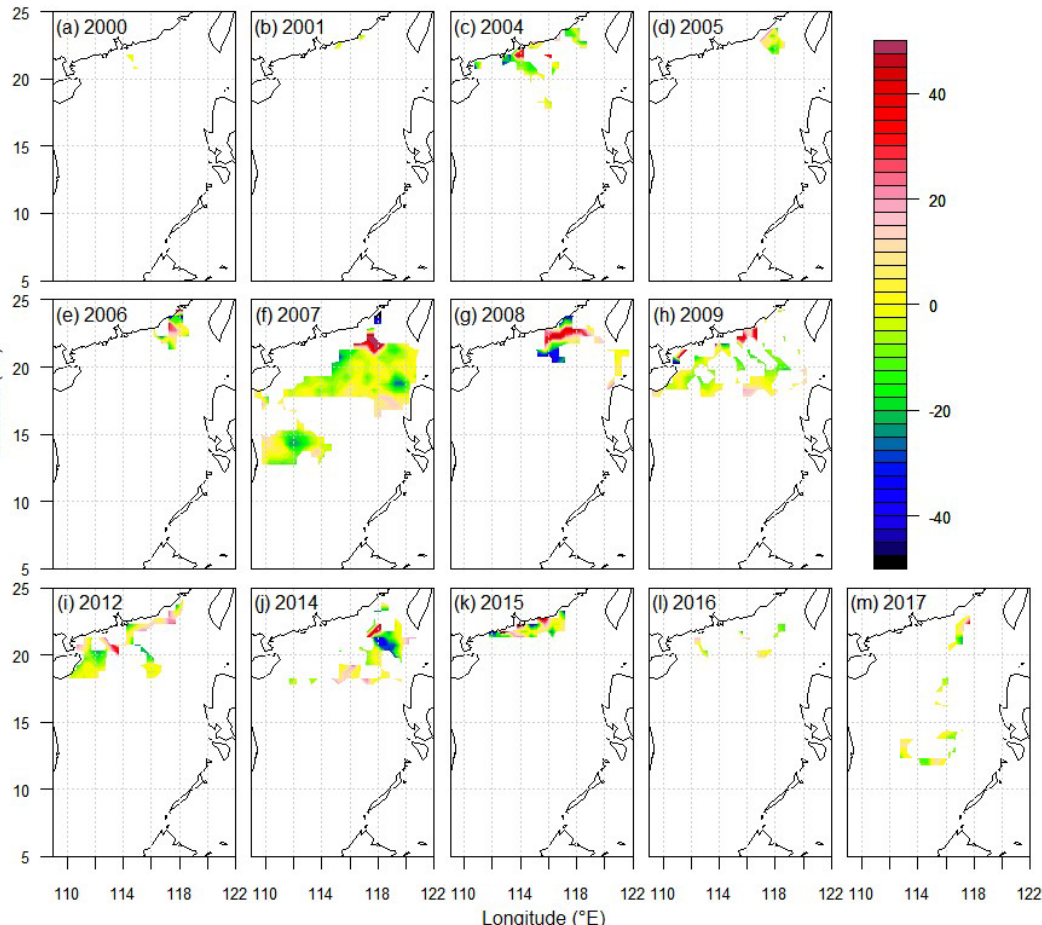
Figure 9. The difference between the reconstructed summer p CO 2 and the observed underway p CO 2 (unit: µatm) in 2000, 2001, 2004–2009, 2012, and 2014–2017.